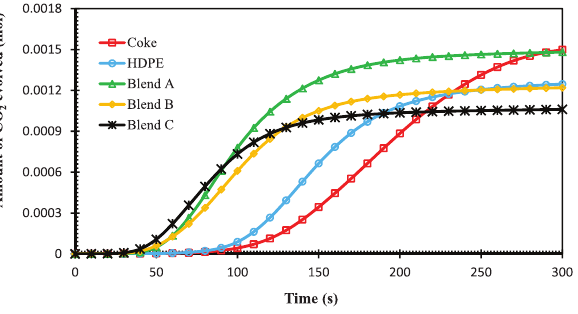
Fig. 12: CO 2 generation as a function of time for each carbonaceous blend at 1150